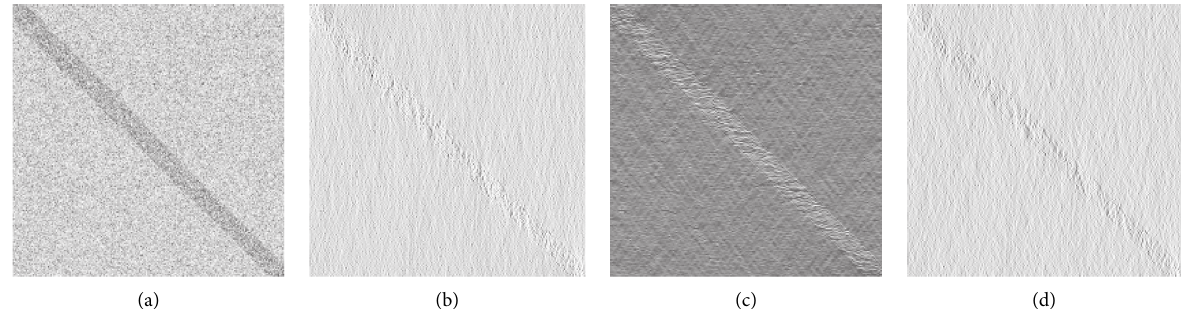
Figure 8: Distribution of principal stress and elastic modulus of the specimen at initial loading. (a) Elastic modulus, (b) maximum principal stress, (c) minimum principal stress, and (d) maximum shear